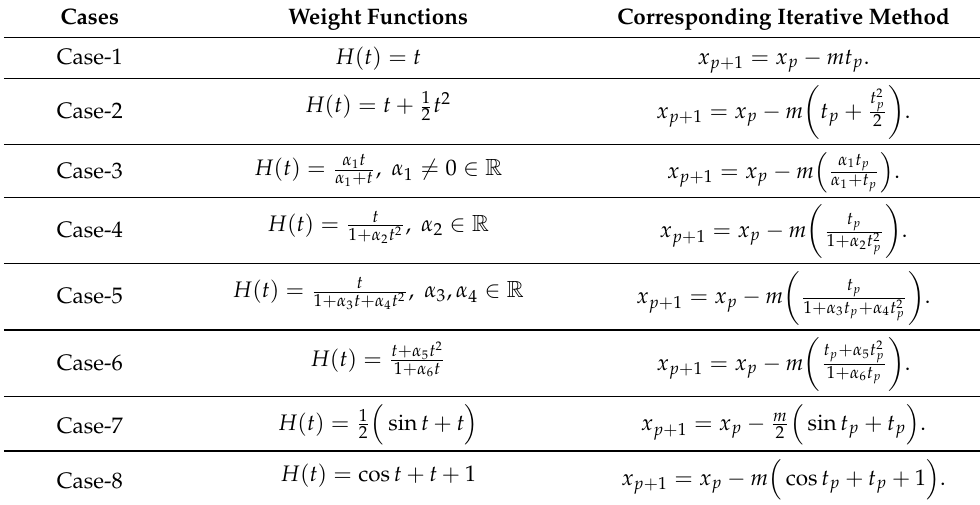
Table 1. Some special cases of our scheme (1) .